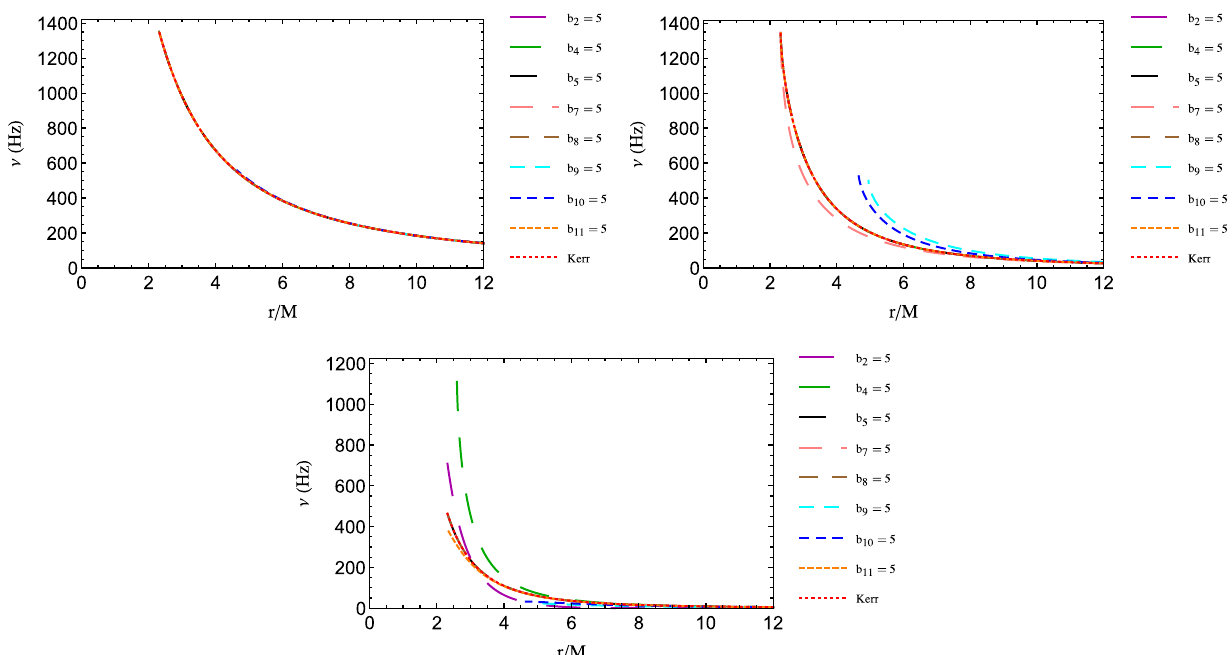
Fig. 3 Impact of all GB parameters on the shape of ν φ (top left panel), ν p (top right panel), ν n (bottom panel). The spin parameter is 0 . 9 and mass is considered as 5 . 4 M (cid:2) . See the text for more